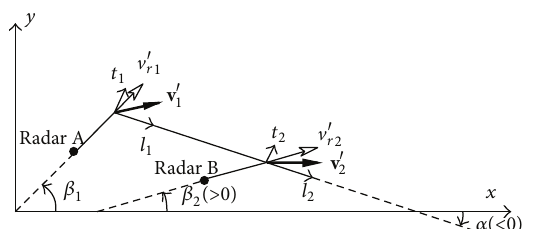
Figure 1: Velocity vectors (bold arrows denoted by v 󸀠 1 and v 󸀠 2 ), their radial components (hollow arrows denoted by V 󸀠 𝑟1 and V 󸀠 𝑟2 ), 𝑙 - components (thin arrows denoted by 𝑙 1 and 𝑙 2 ), and 𝑡 -components (thin arrows denoted by 𝑡 1 and 𝑡 2 ) at two correlated points x 1 = , 𝑦 ) and x = (𝑥 , 𝑦 ) . Angles 𝛼 , 𝛽 𝛽 (𝑥 1 1 2 2 2 1 , and 2 are defined in the text. The two black dots mark the locations of radar 𝐴 and radar 𝐵 at x 𝐴 and x 𝐵 ,